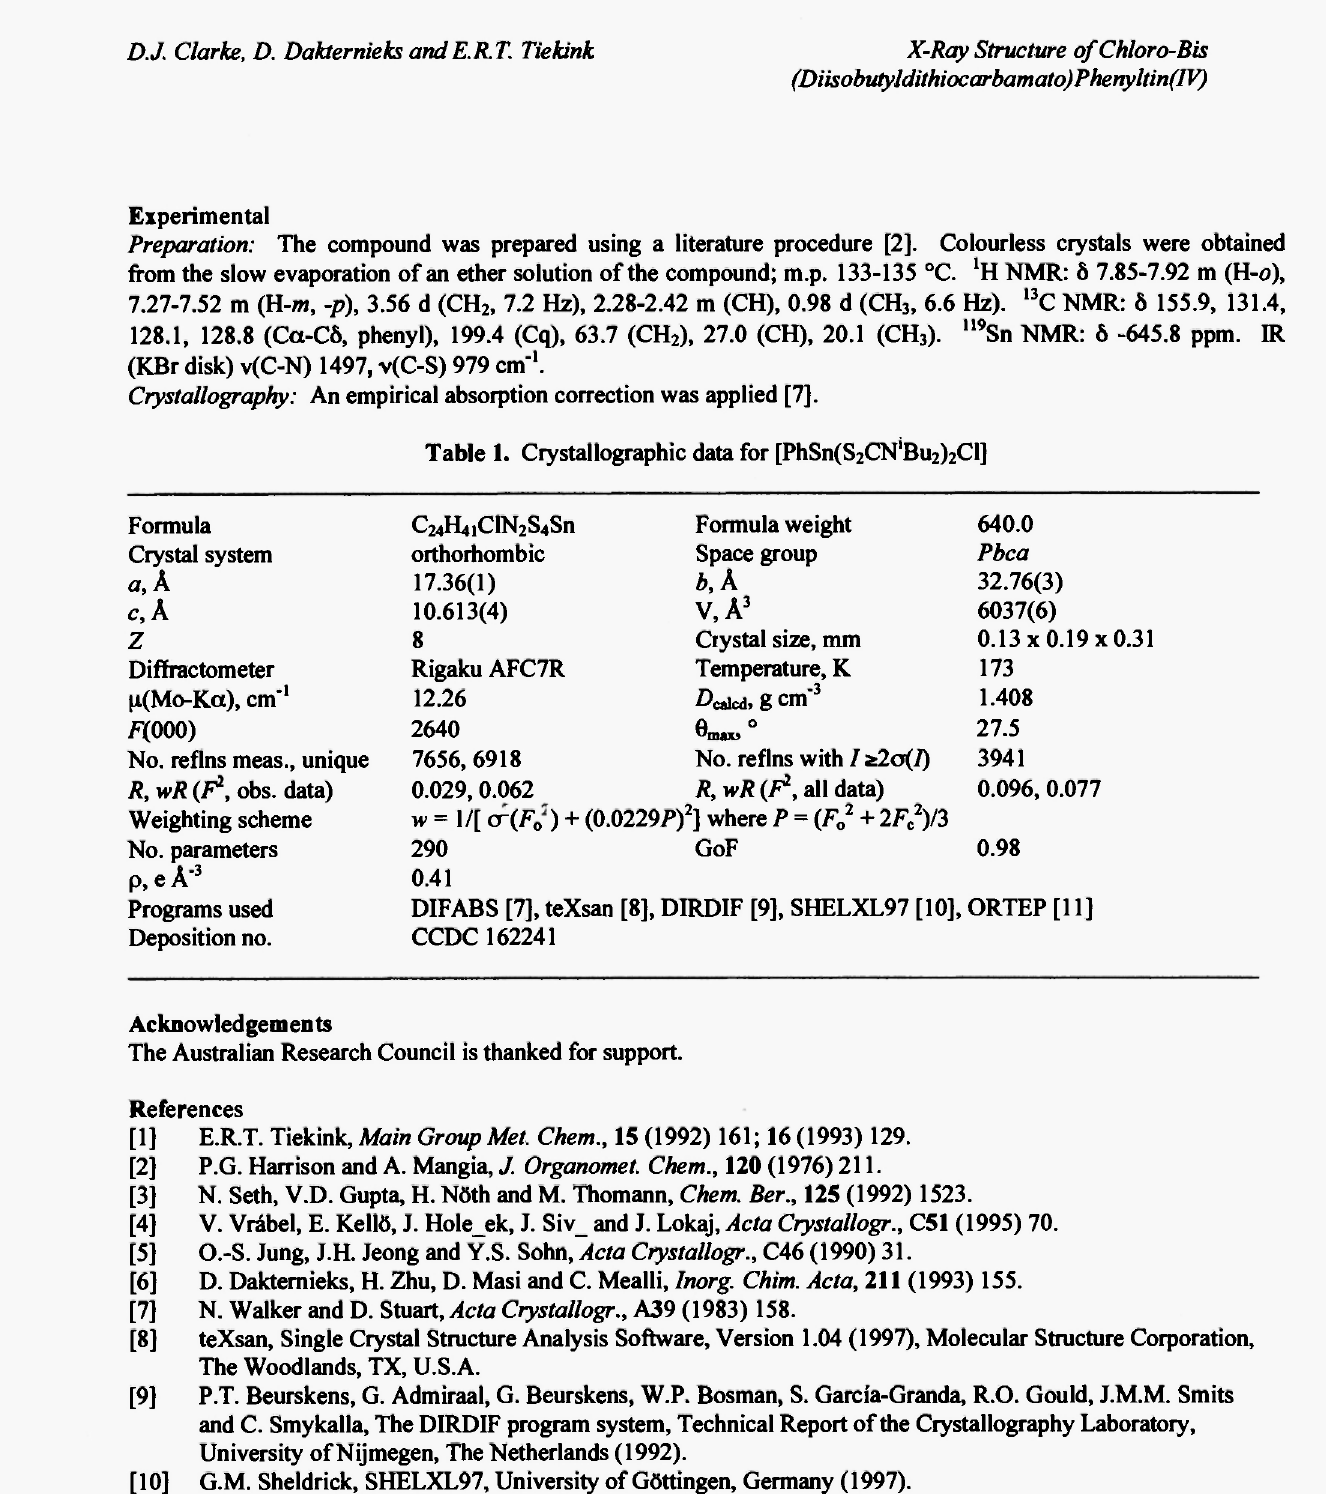
Table 1. Crystallographic data for [PhSn(S